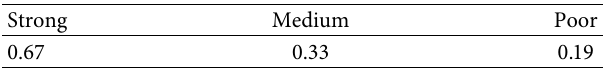
Table 7: Appropriate index of CV Red (Cohen, 2009).